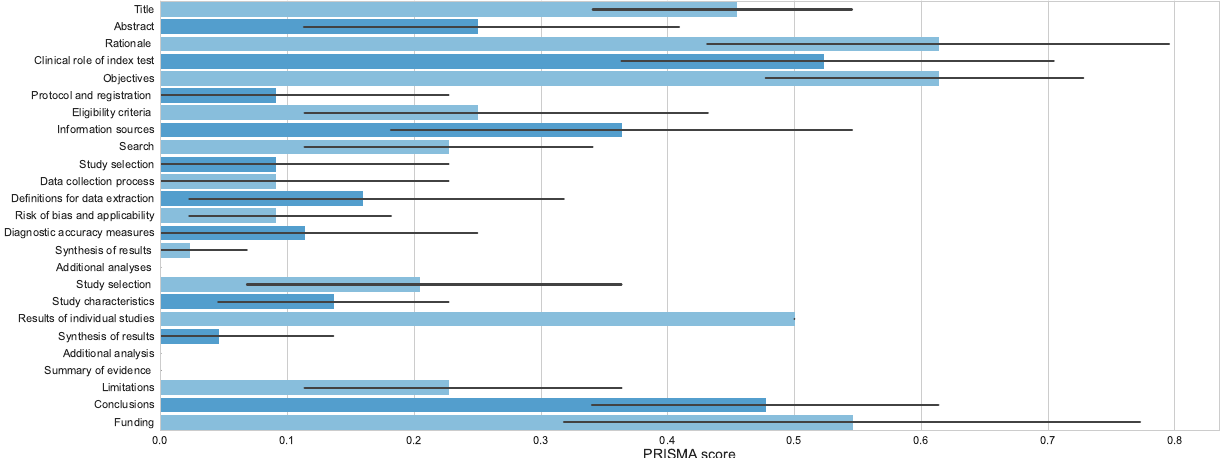
Figure 3. Quality of reporting graph: our judgements about each PRISMA-DTA item presented as averages (with 95% confidence intervals—black lines) across all included studies. Different shades of blue are used just to improve the chart’s clarity.